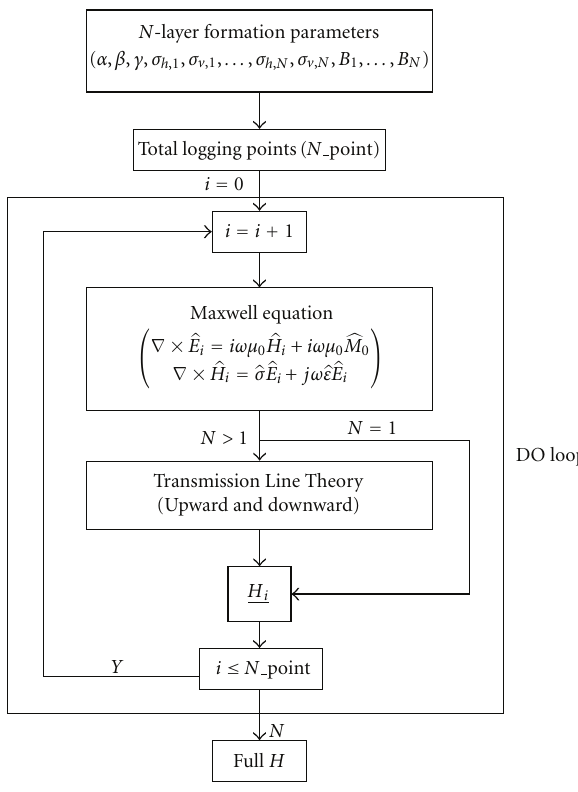
Figure 3: Flow chart of the serial forward